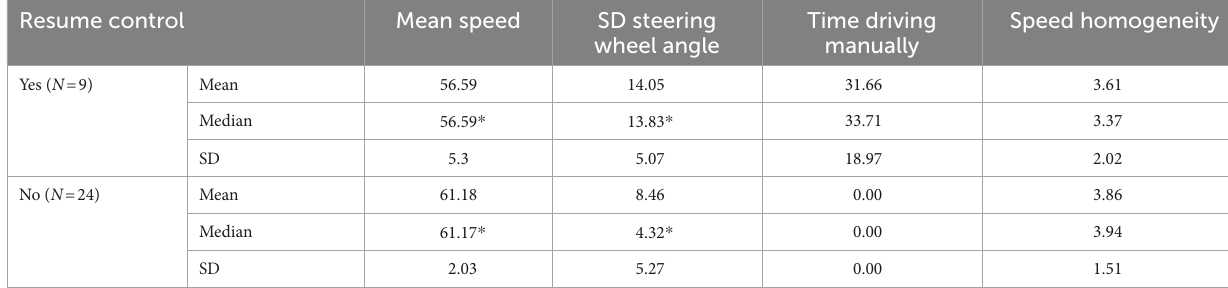
TABLE 2 Driving performance measures for the explicit failure condition. Resume